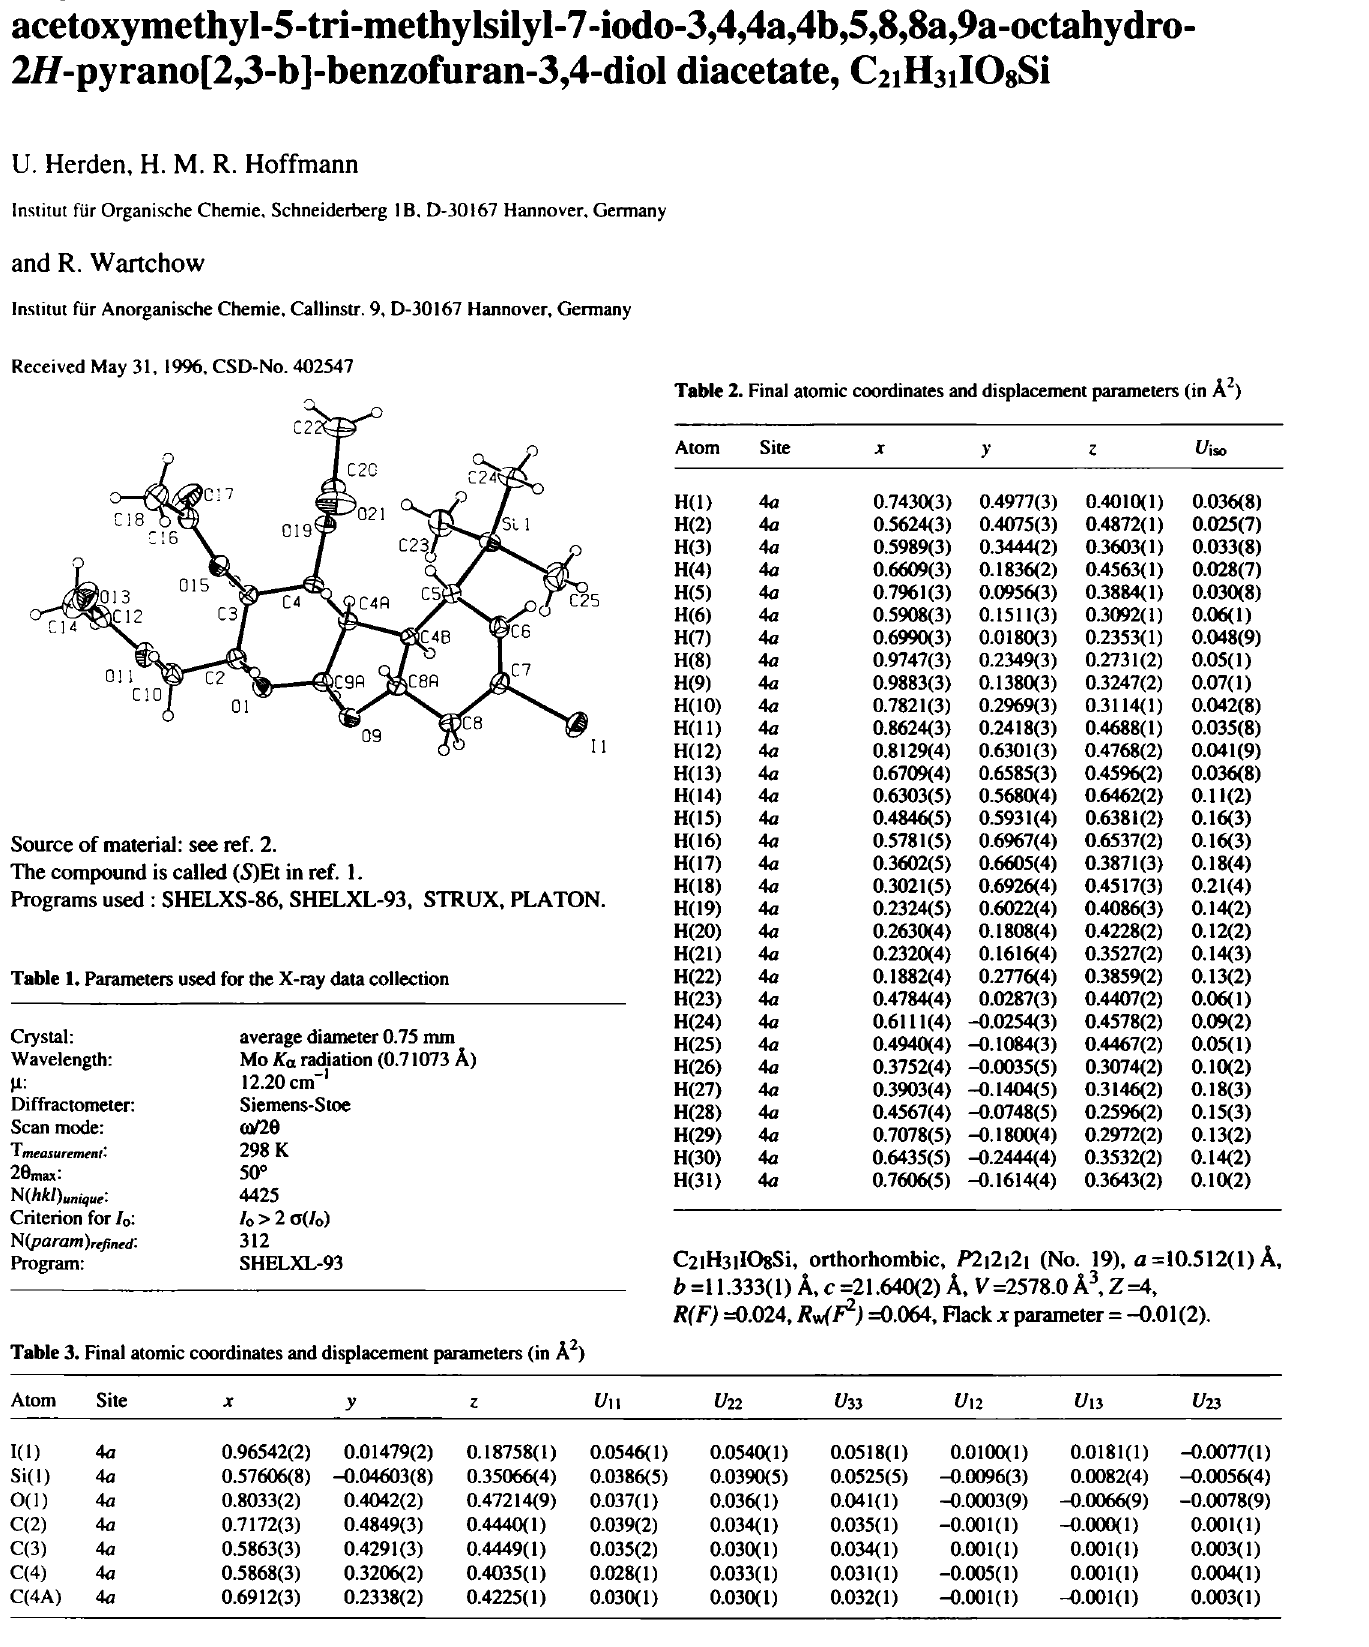
Table 3. Final atomic coordinates and displacement parameters (in Â 2 ) Atom